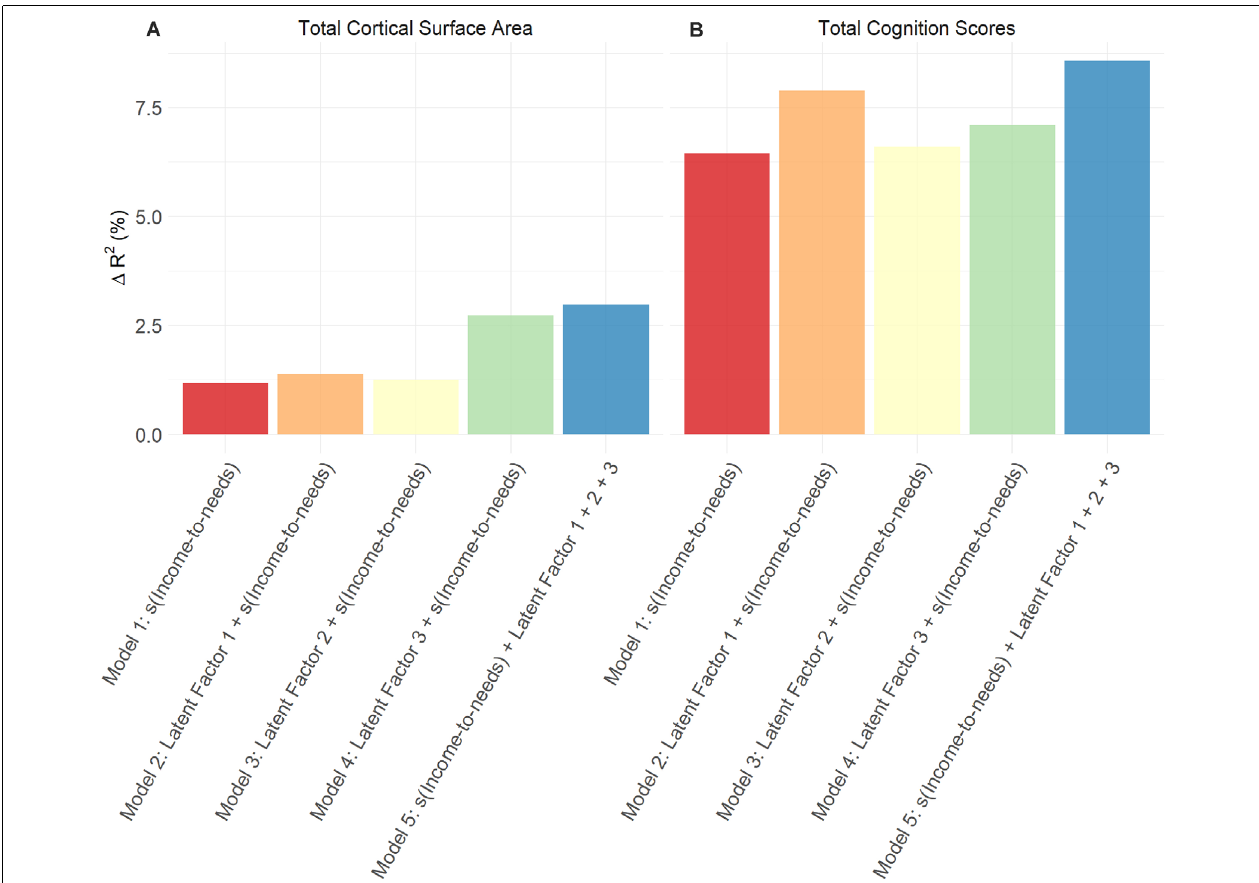
FIGURE 4 | For each developmental measure (A) total cortical surface area and (B) total cognition scores, effect sizes are shown as the percent of variance statistically attributable to the INR only, each latent factor, and to the additive effect of the INR and all latent factors combined. Change in adjusted R 2 was calculated by comparing each separate model to the null model (fixed effects of covariates and random effects